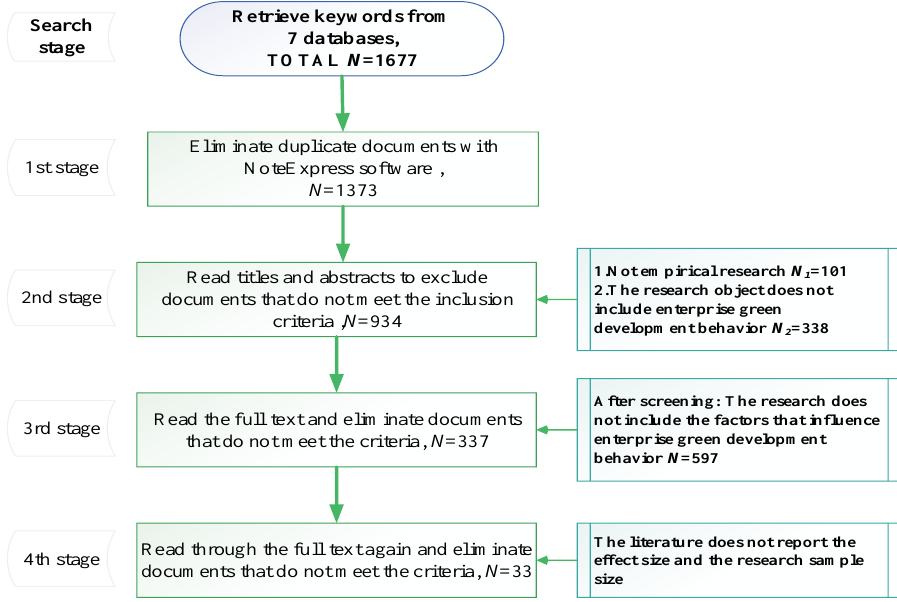
Figure 2. Selection